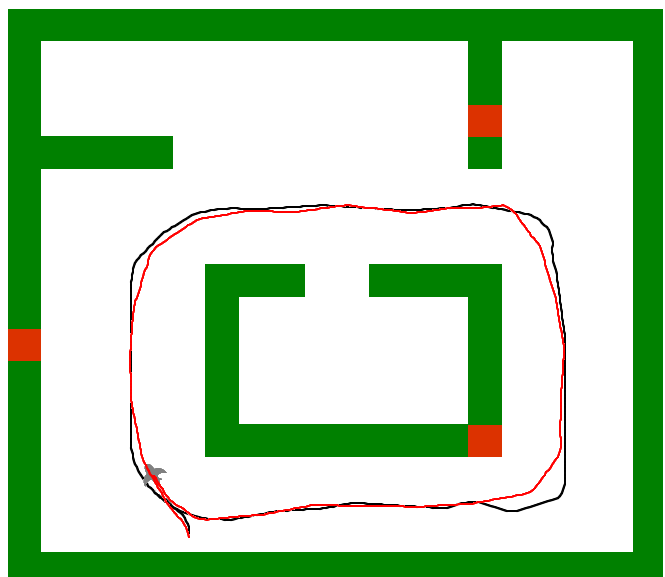
Figure 12. Forward navigation: the agent autonomously follows the path given by a sequence of place cell starting in the bottom left. The autonomous trajectory (red) is very close to the manual trajectory (black).